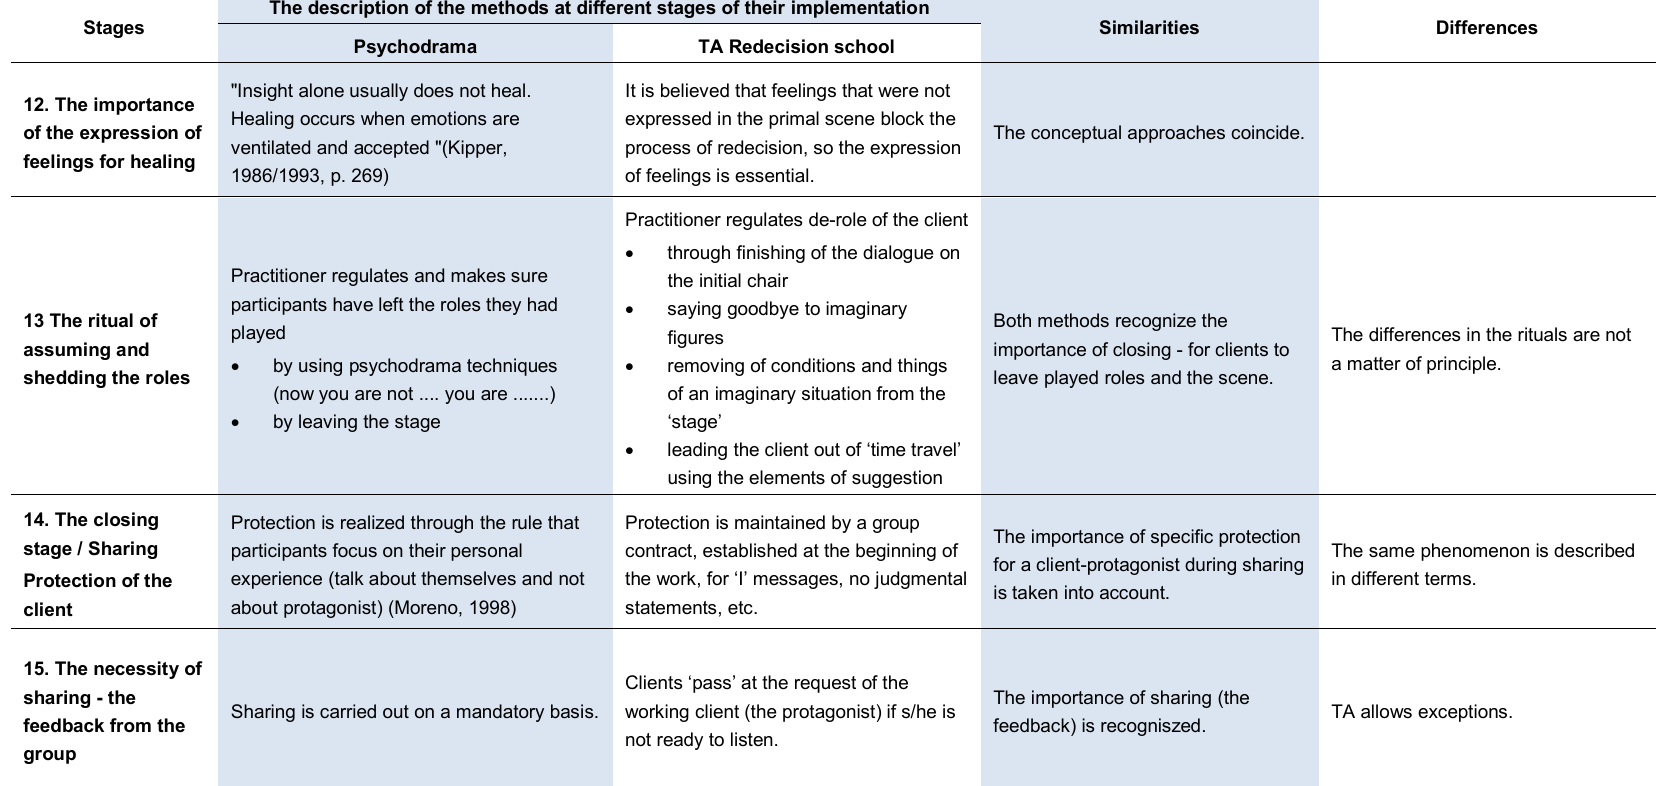
Table 2 Comparison of TA redecision method and